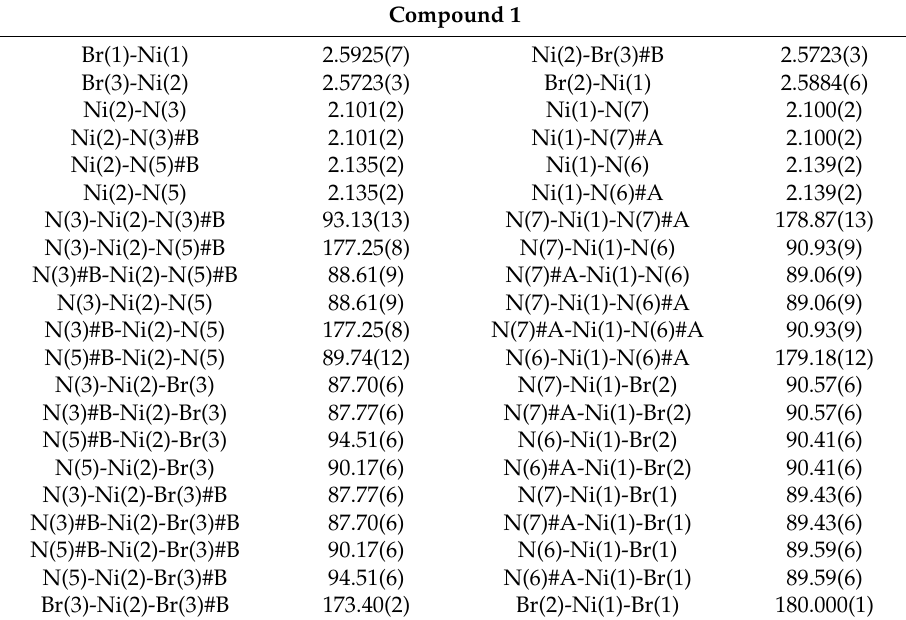
Table 2. Selected bond distances (Å) and angles ( o ) for compound 1